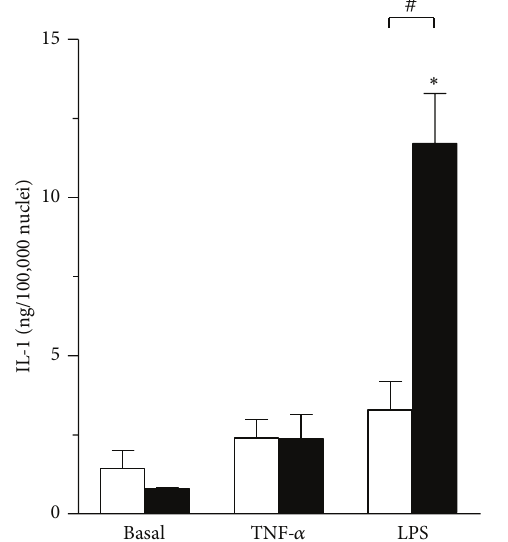
Figure 2: IL-1 secretion from cultured skeletal muscle cells is increased after removal of TNF- 𝛼 and LPS treatment. Human myoblasts (white bars) and myotubes (black bars) were exposed to TNF- 𝛼 (100ng/mL) or LPS (100ng/mL) or vehicle (Basal) for 24 hours. Medium containing TNF- 𝛼 or LPS was removed and replaced with growth medium. IL-1 secretion was estimated by ELISA 24hours after compound removal. Data are means ± SEM ( n = 4–6). ∗ P < 0.05 versus respective Basal. # P < 0.05 myoblasts versus myotubes (95% CI of difference: 5.28 to 11.56).